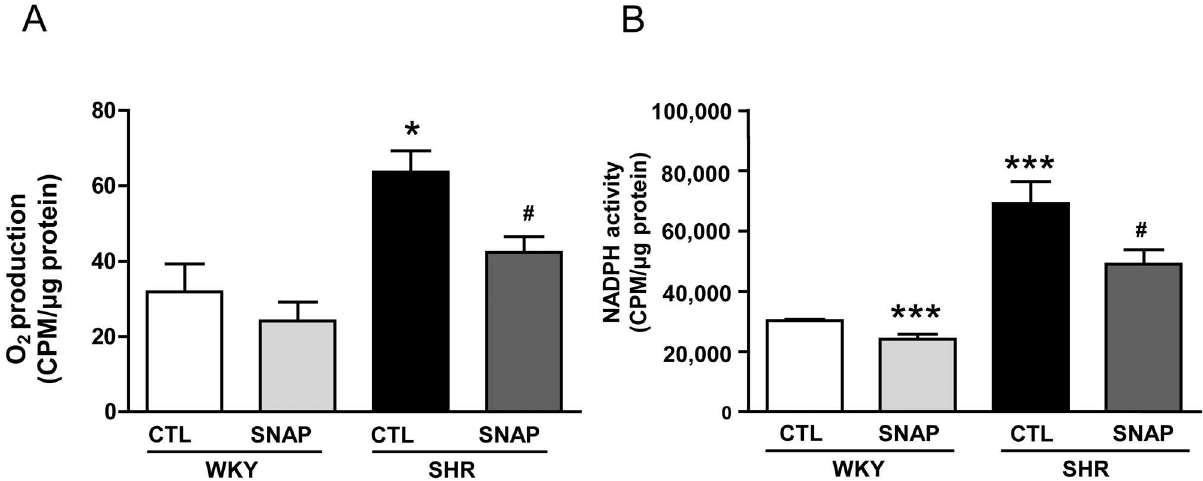
Fig 5. Effect of SNAP on superoxide anion (O2 − ) production and NADPH oxidase activity in VSMC from 12-weekold SHR and age- matched WKY rats. ConfluentVSMC from 12-week-old SHR and age-matched WKY rats were incubatedin the absence(control) and presence of SNAP (100 μ M) for 24 h and O 2 − production (A) and NADPH oxidaseactivity (B) were determined as describedin Materialsand methods. Values are mean ± SD of 5 separate experiments using different cell populationsfrom different animals. * P < 0.05, *** P < 0.001 vs WKY CTL group; # P < 0.05vs SHR CTL